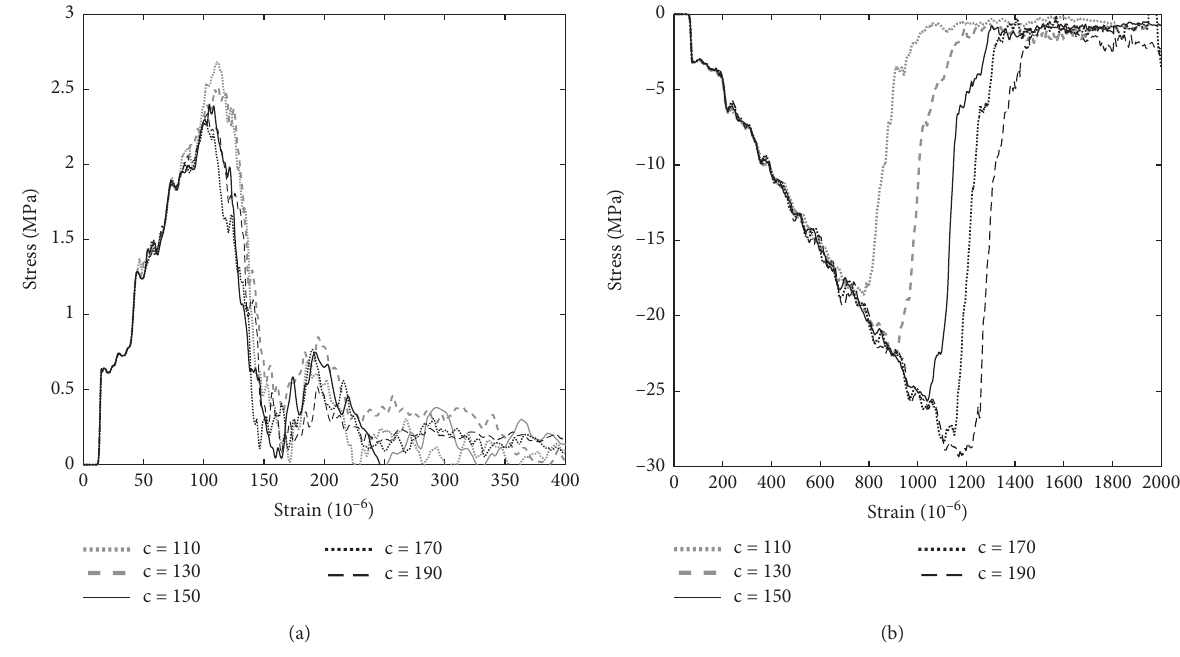
Figure 14: Parametric study of the parameter c